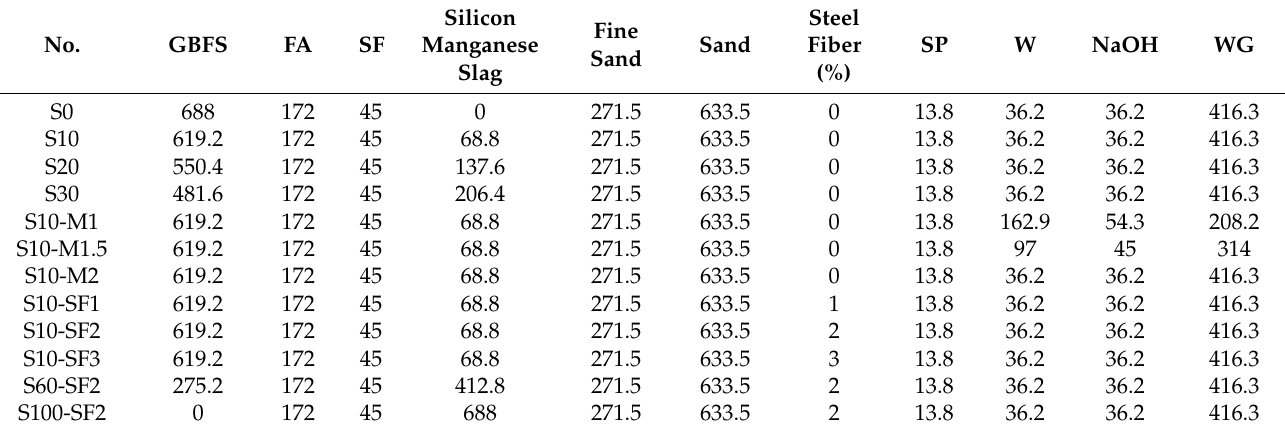
Table 7. Mix proportion of AASSC (kg/m 3